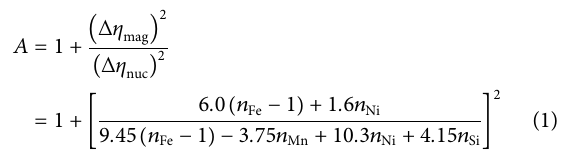
Nanovoids or diluted